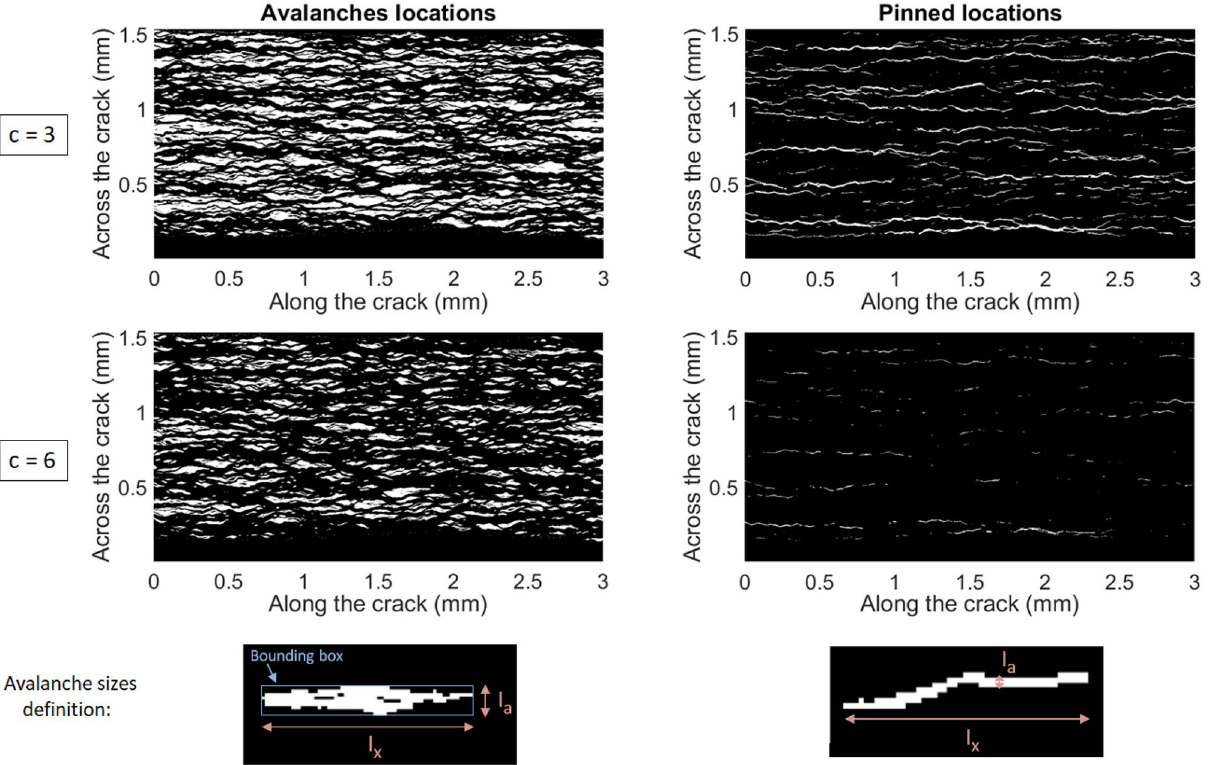
Figure 7. Positions of the avalanches (left) and pinning locations (right) in the front local velocity map V ( x , a ) shown in Fig. 3c, as per Eqs. (10) and (11). Two thresholds are here used to define these maps relatively to the mean velocity: c = 3 and c = 6 . The white areas are the locations of interest, of surfaces S , crossline extents l x and inline extents l a . Bottom images: Difference in definition of l a for the avalanche (or depinning) and pinning clusters shown in Fig. 7. For the former, l a is the maximum extent along the a direction. For the latter it is the average width in the same direction. In both cases, l x is the maximum extent along the x direction and S the full surface (in white) of the cluster. The square pattern marks the pixel size ( (cid:31) x = (cid:31) a = 3 µ